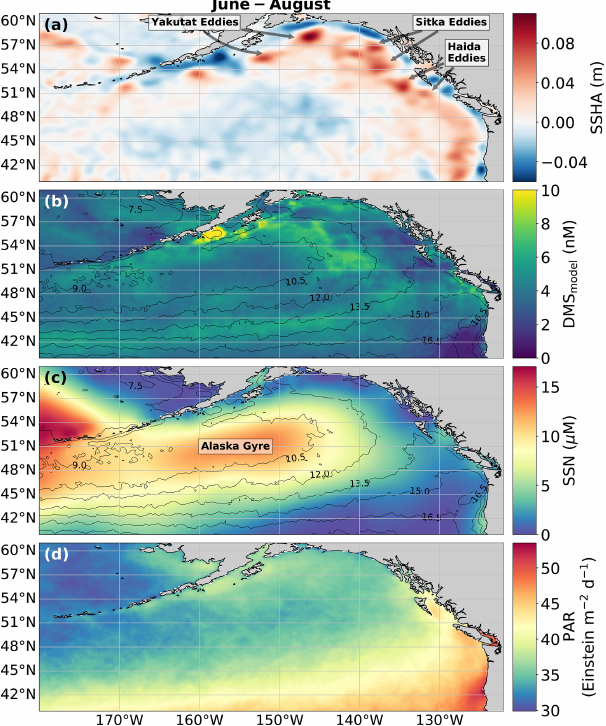
Figure 8. Physical drivers of summertime (June–August) NESAP DMS distributions. (a) Sea surface height anomalies (SSHAs), (b) predicted DMS concentrations derived from the mean of all 2000 RFR and ANN machine-learning models, (c) sea surface ni- trate (SSN), and (d) photosynthetically active radiation (PAR). Con- tours in (b) and (c) show sea surface temperature (SST) isotherms. Coherent features of elevated sea surface height indicate the pres- ence of mesoscale eddies, whereas nearshore low SSHA features reveal areas of upwelling. Colormap ranges are restricted to illus- trate trends with < 1% of data exceeding the colorbar